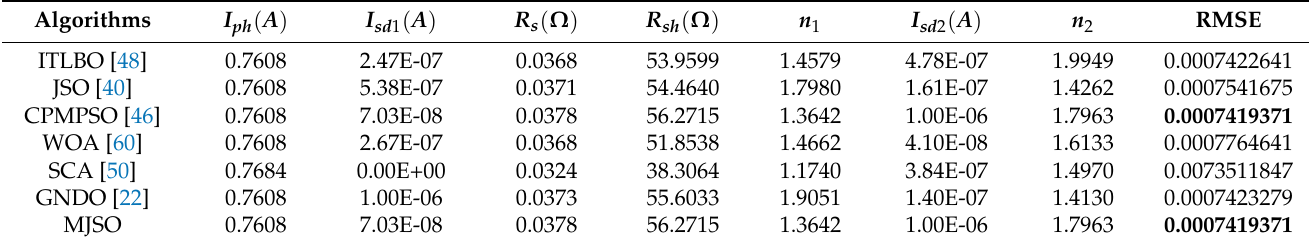
Table 8. Comparison on the DDM in terms of obtained parameter and the corresponding RMSE.